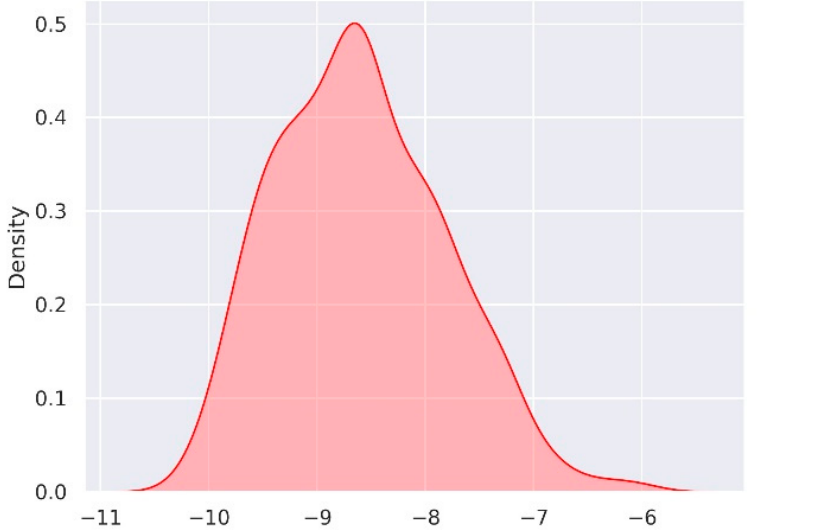
Figure A4. Distributions of the docking scores of the generated molecules for S1PR1.